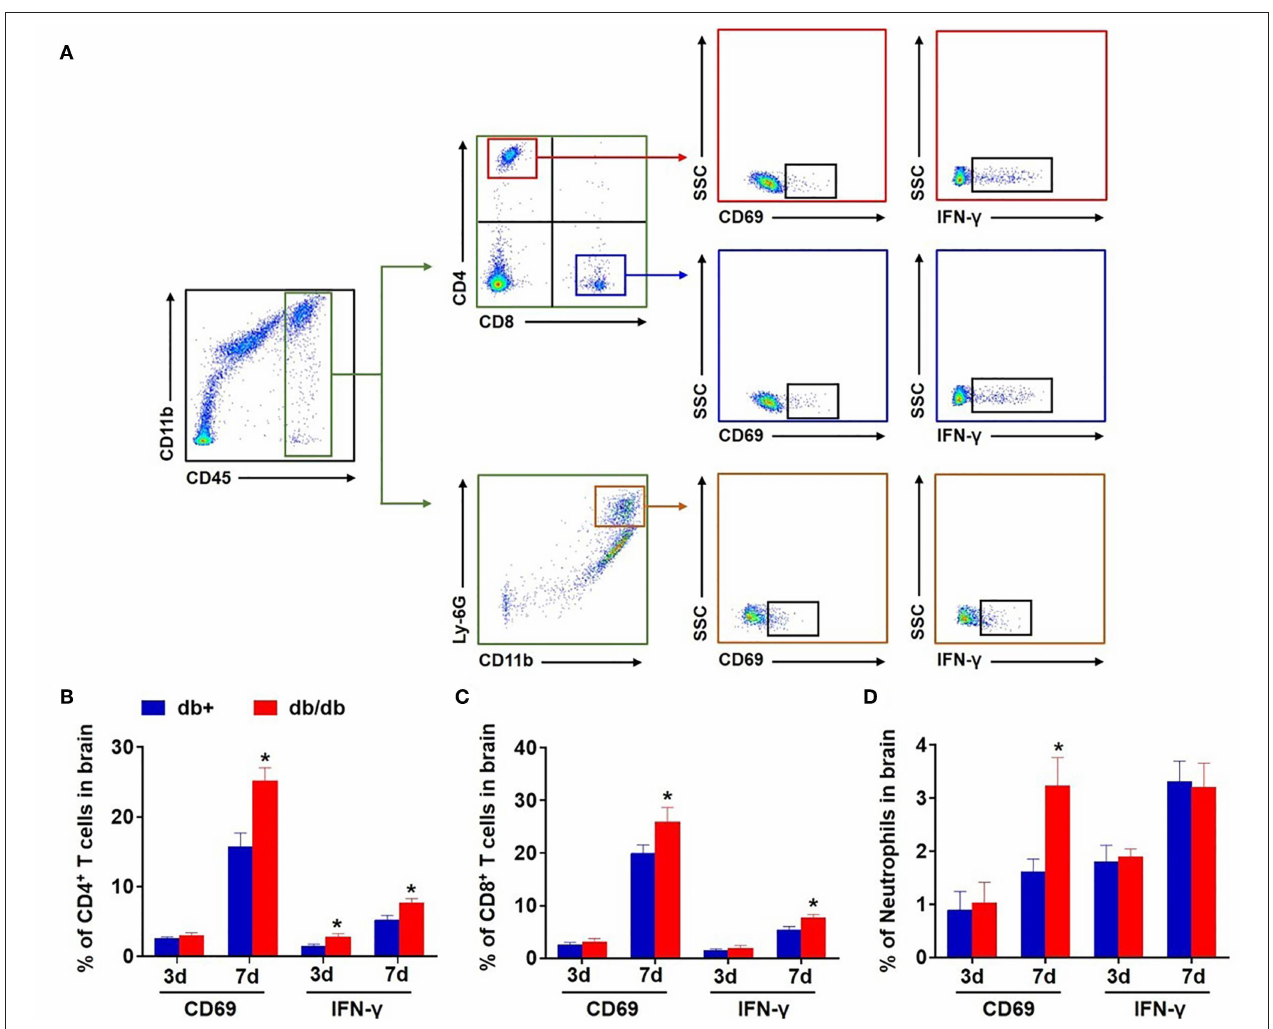
FIGURE 5 | Upregulation of CD69 and IFN- γ in brain-infiltrating T cells and neutrophils in db/db mice subjected to dMCAO. (A) Gating strategy of brain-infiltrating CD4 + T, CD8 + T cells, and neutrophils expressing CD69 and IFN- γ after dMCAO. The counts of CD4 + T (B) , CD8 + T cells (C) , and neutrophils (D) expressing CD69 and IFN- γ in groups of db/ + and db/db mice at indicated time points after dMCAO. Mean ± s.e.m.; * p < 0.05: db/ + vs. db/db at the same time point, n = 8 per